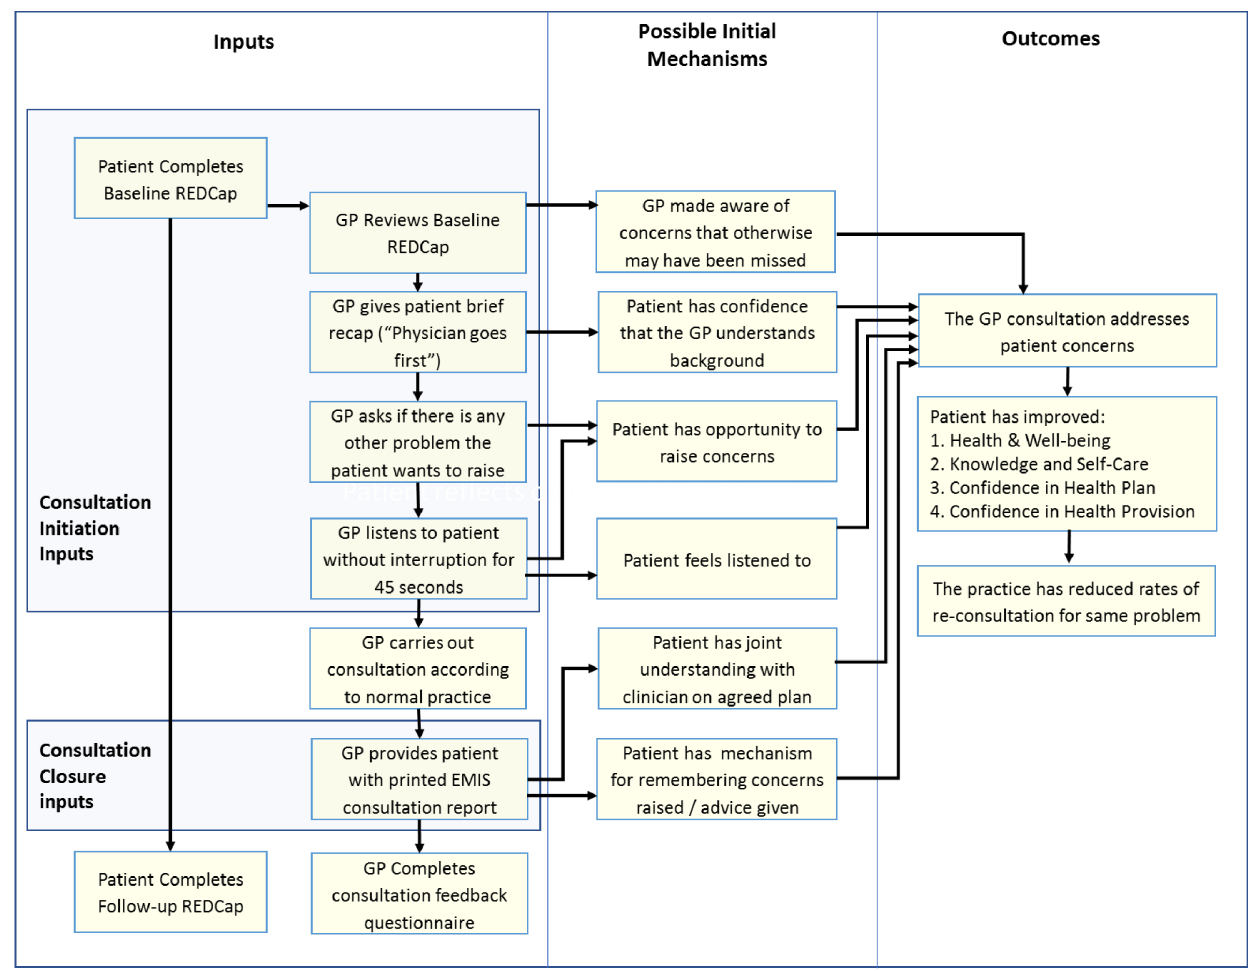
Figure 3. Proposed initial programme theory of